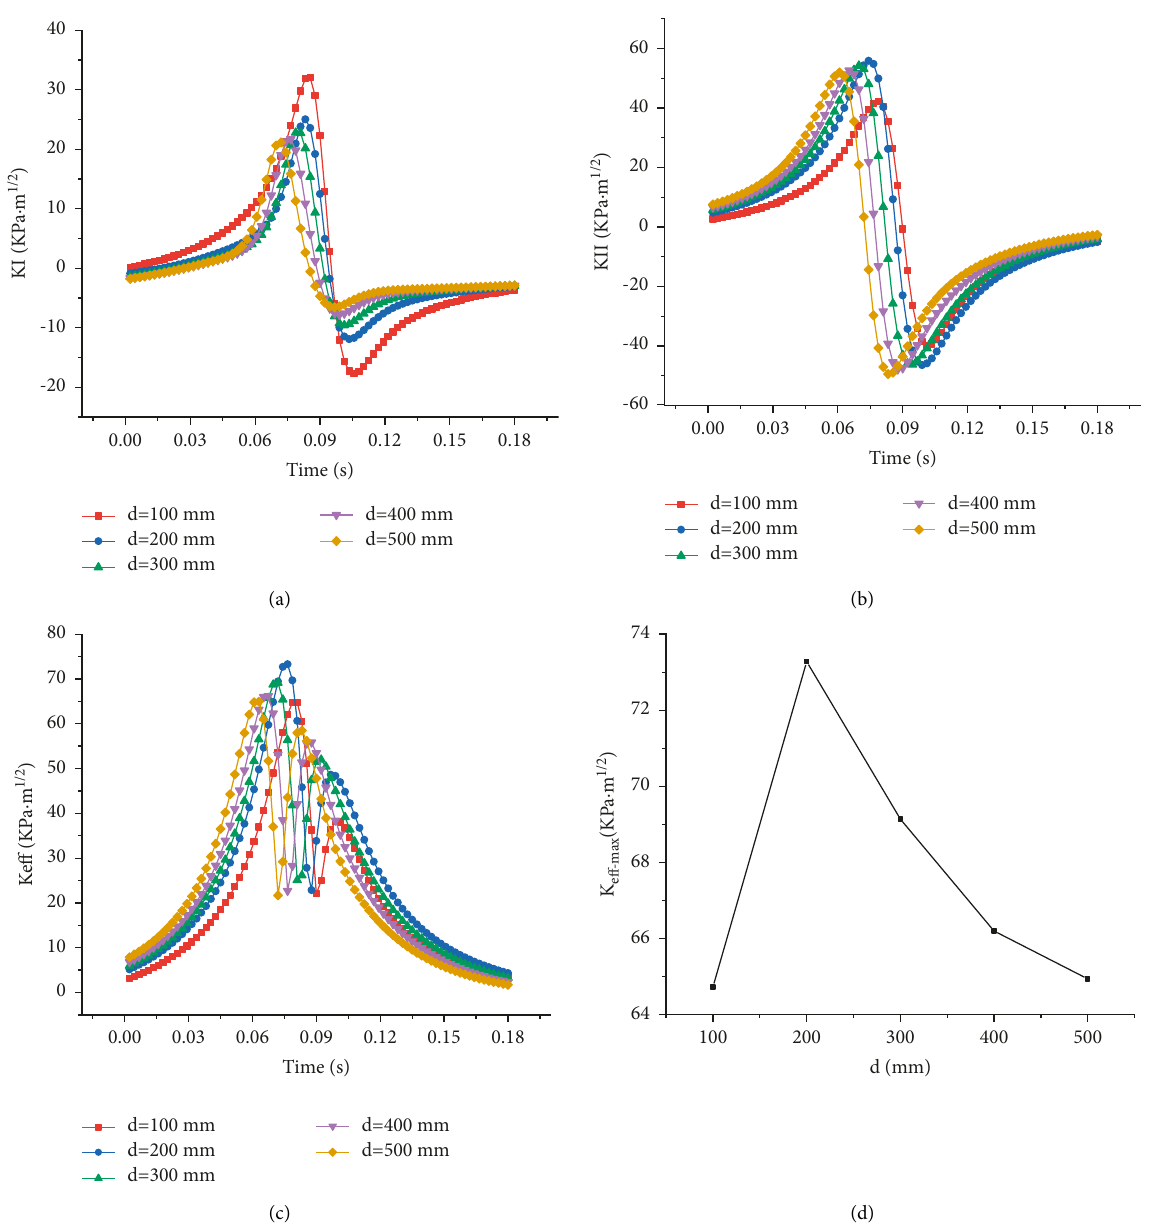
Figure 5: The SIF of nonpenetrating crack time history curve with various spacings. (a) KI; (b) KII; (c) Keff; (d)